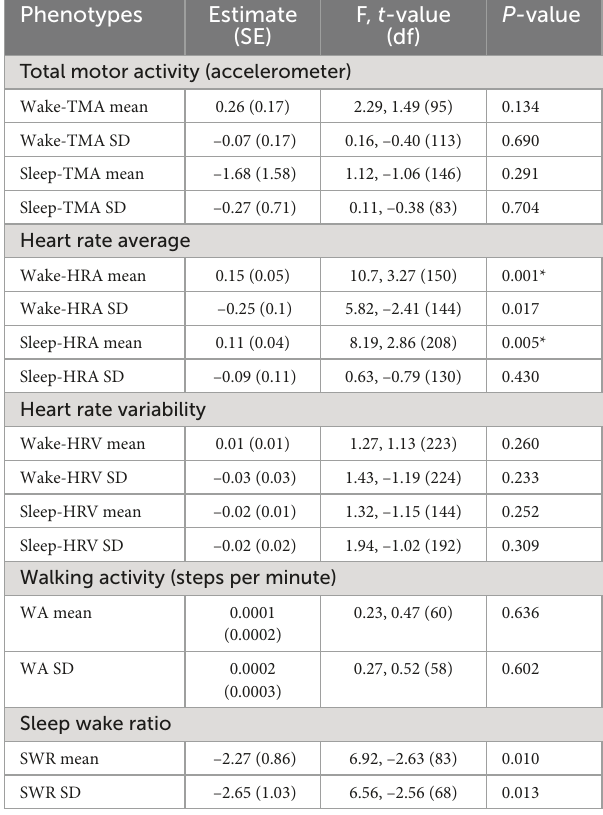
TABLE 2 Digital phenotypes predicting positive